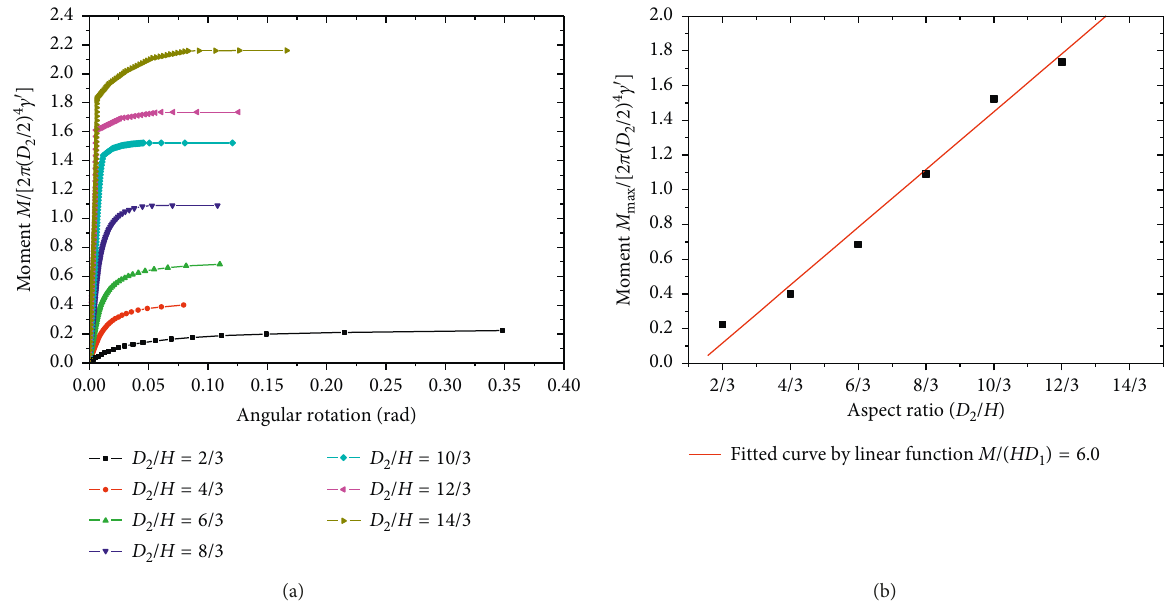
Fitted curve by linear function M /( HD 1 ) = 6.0